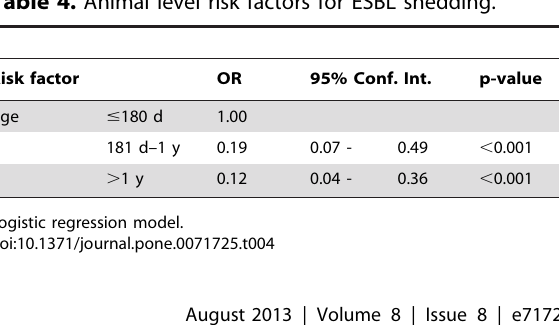
Table 3. Farm level risk factors for ESBL shedding.